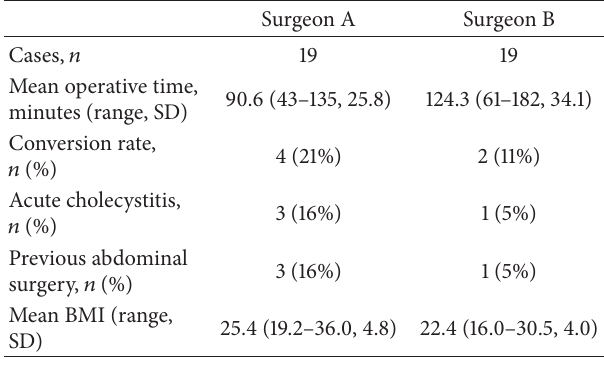
Table1:Operativeandpatientprofileofthefirst19casesofSurgeons A and B.